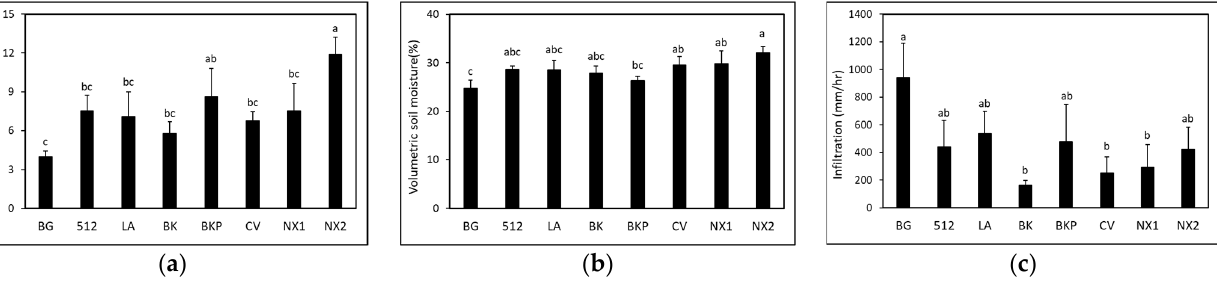
Figure 5. Effect of SSgH on ( a ) soil respiration, ( b ) volumetric soil moisture, and ( c ) infiltration rate. Means ( n = 4) followed by the same letter(s) are not different according to Waller–Duncan k -ratio ( k = 100) t -test.